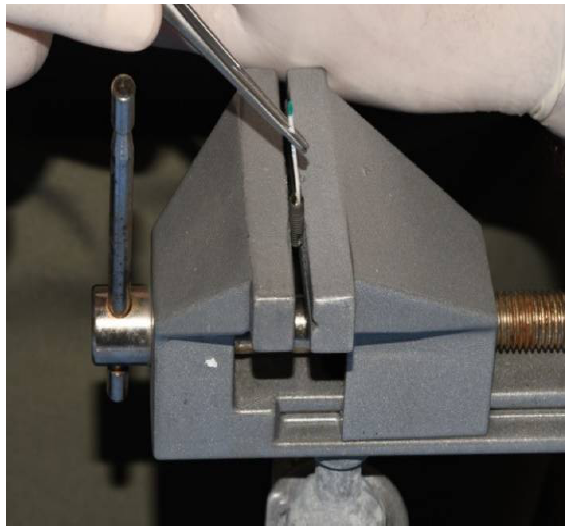
Figure 6. Sampling the implants with paper points.